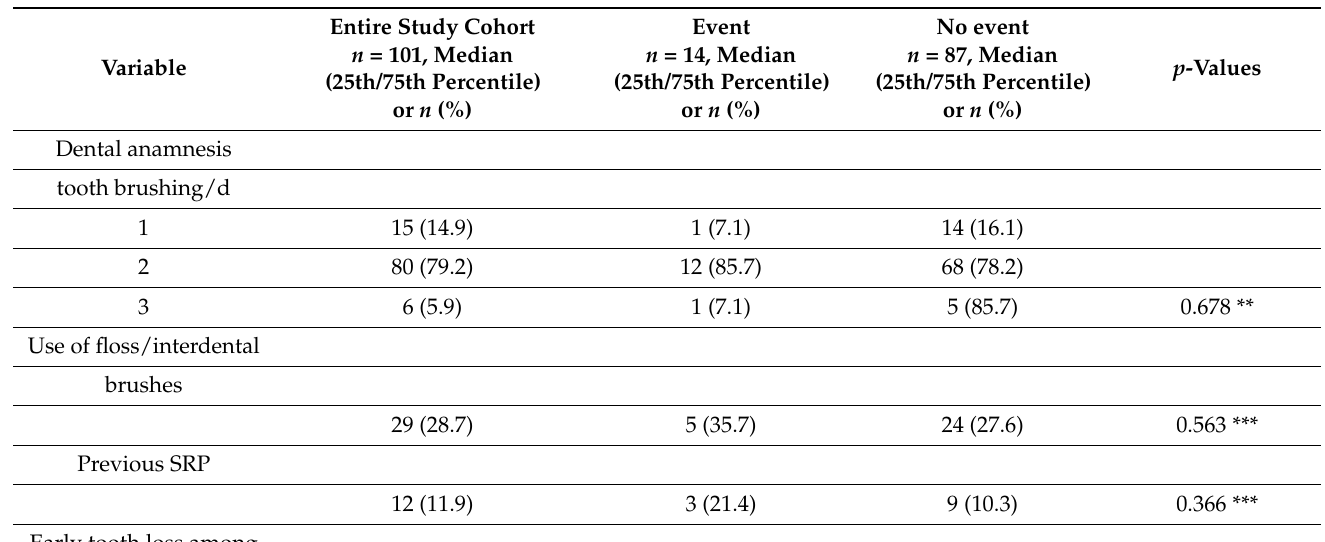
Table 3. Dental conditions in dependence of the occurrence of adverse cardiovascular events one year after CABG surgery. Significant differences are indicated with